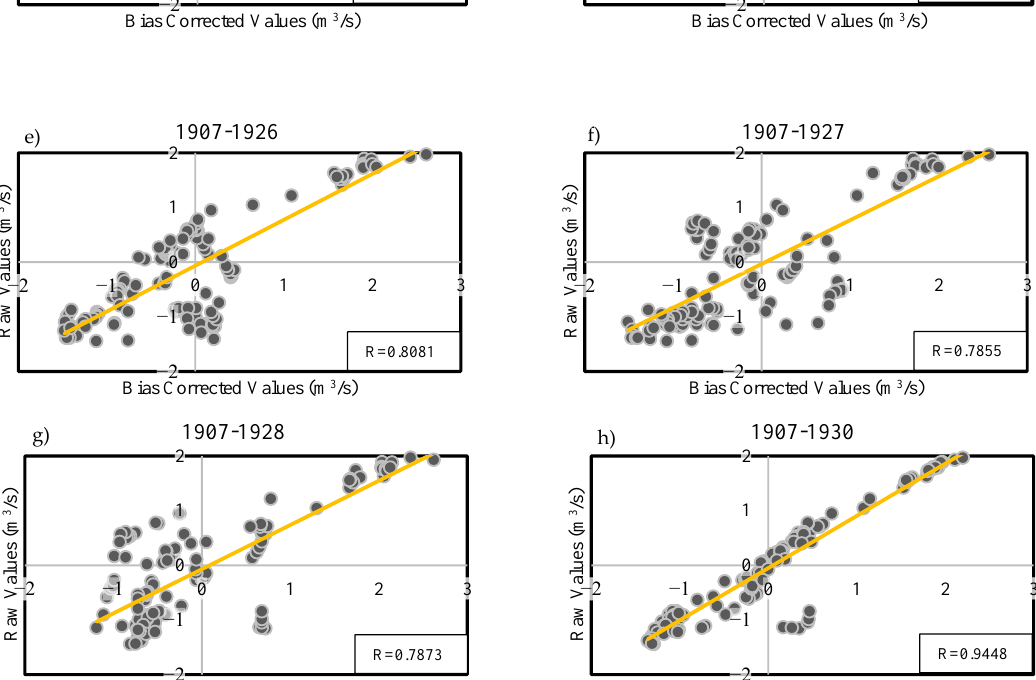
Figure 13. RMSE and MAE values for the SDI results. (a) RMSE results, (b)MAE results. Contour mappings were created between the target station SDI and the index values generated by the flow rates (Figure 14).